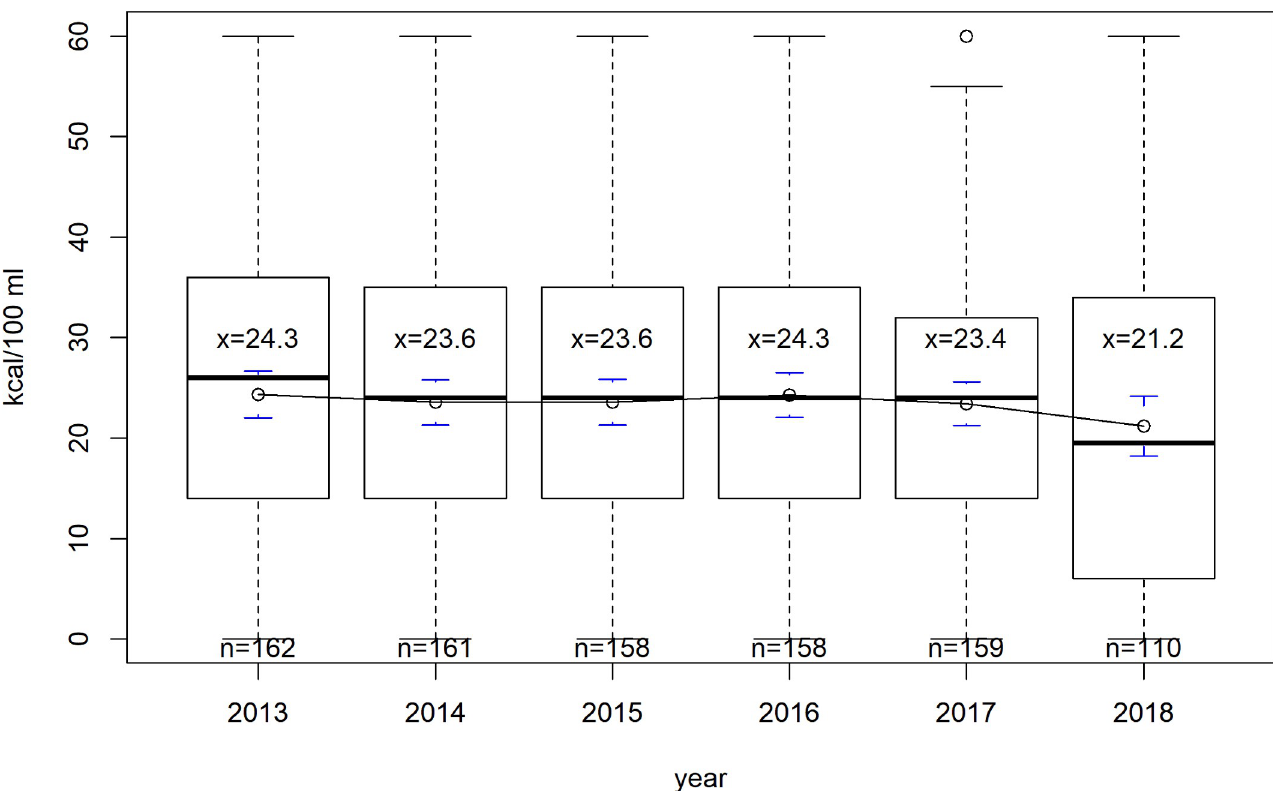
Fig 1. Time trend of the average energy intake from sugar-sweetened beverages (in kcal/100 ml) per sugar-sweetened beverage product, using market data.